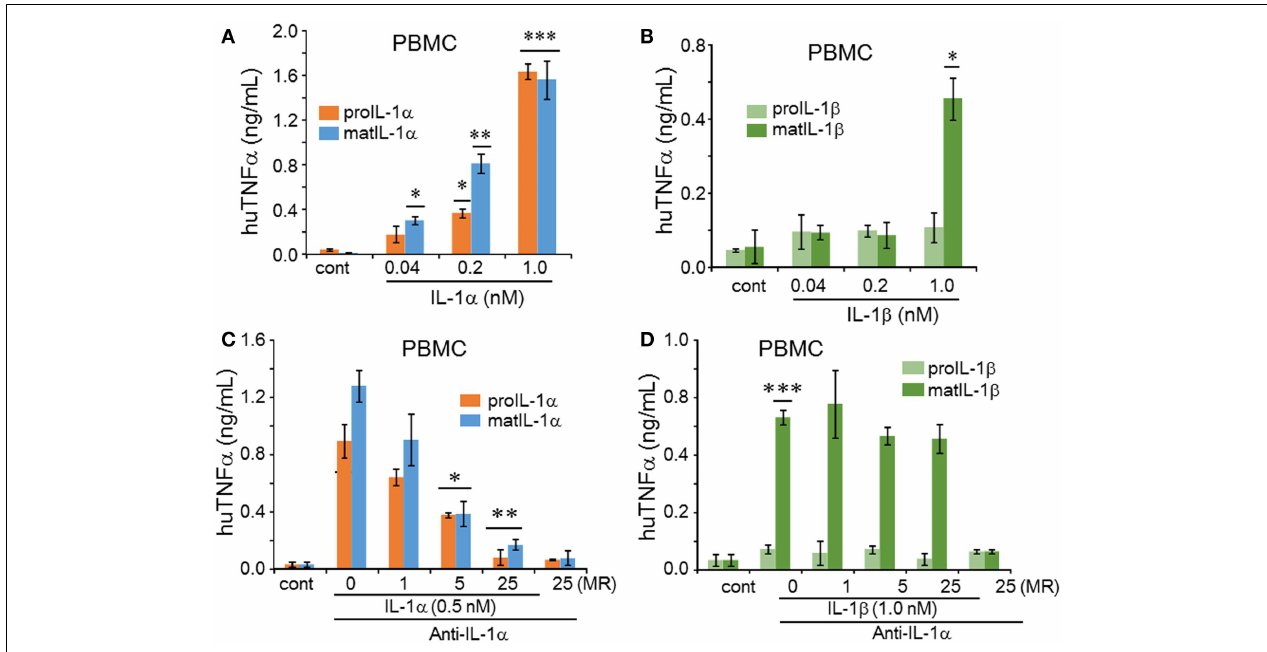
inhibition of anti-IL-1 α in precursor or mature recombinant IL-1 α -inducedTNF α levels (D) that of precursor or mature recombinant IL-1 β -inducedTNF α levels were measured in supernatants from Figures 3C,D , respectively. Data are mean ± SEM; * p < 0.05; ** p < 0.01; *** p < 0.001 compared to control (cont). PBMC data are representative of one of two donors performed in